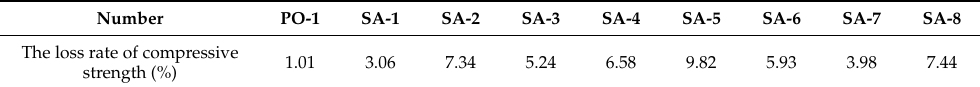
Table 4. Loss rate of compressive strength of cement paste after carbonation.